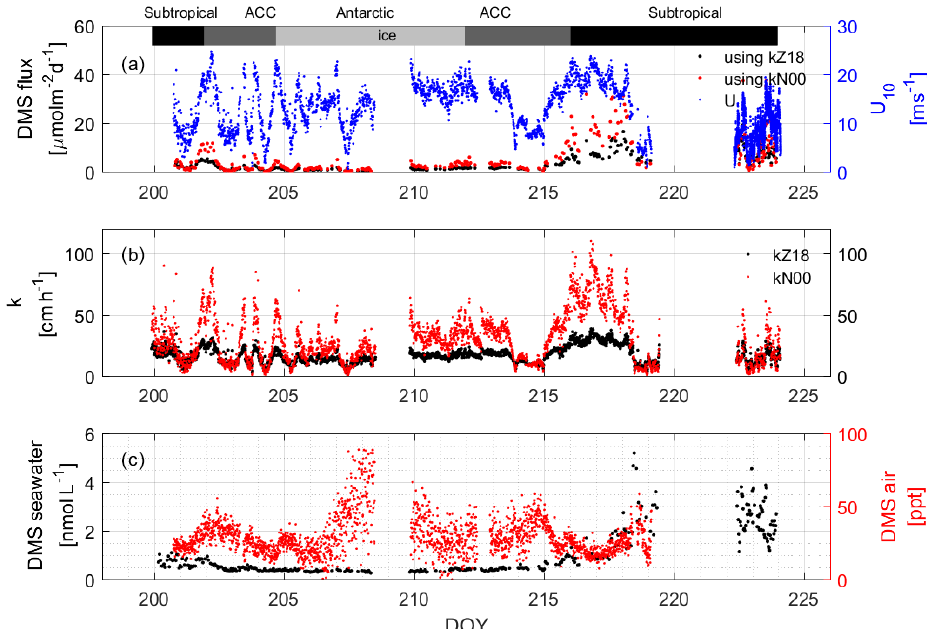
Figure 8. (a) Calculated DMS fluxes that depend on the indicated wind speeds ( U from 10m) using (b) two different k values. The measured water and air values that were used to compute the concentration difference are shown in (c) . The bars across the top of the figure denote the different hydrographic regions discussed throughout the text.